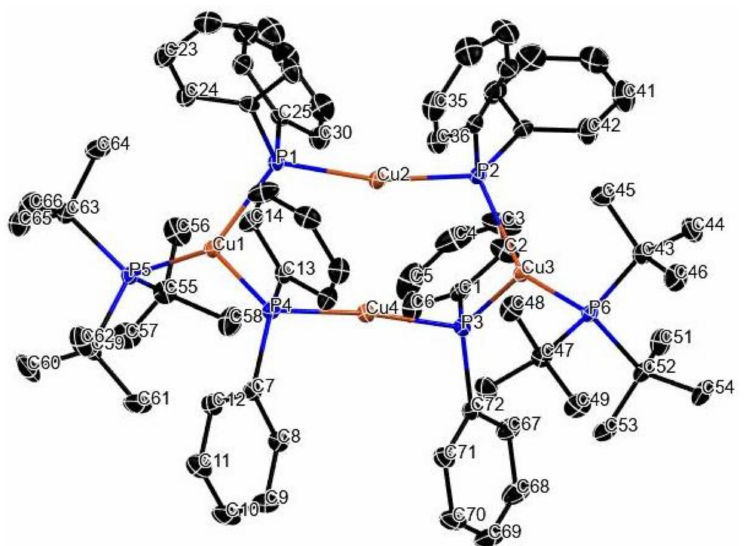
Figure 1. Molecular structure of 1 with thermal ellipsoids drawn at the 30% probability level. Hydrogen atoms and two non-coordinated THF molecules of solvation are omitted for clarity. Full labeling scheme is shown in the Supplementary